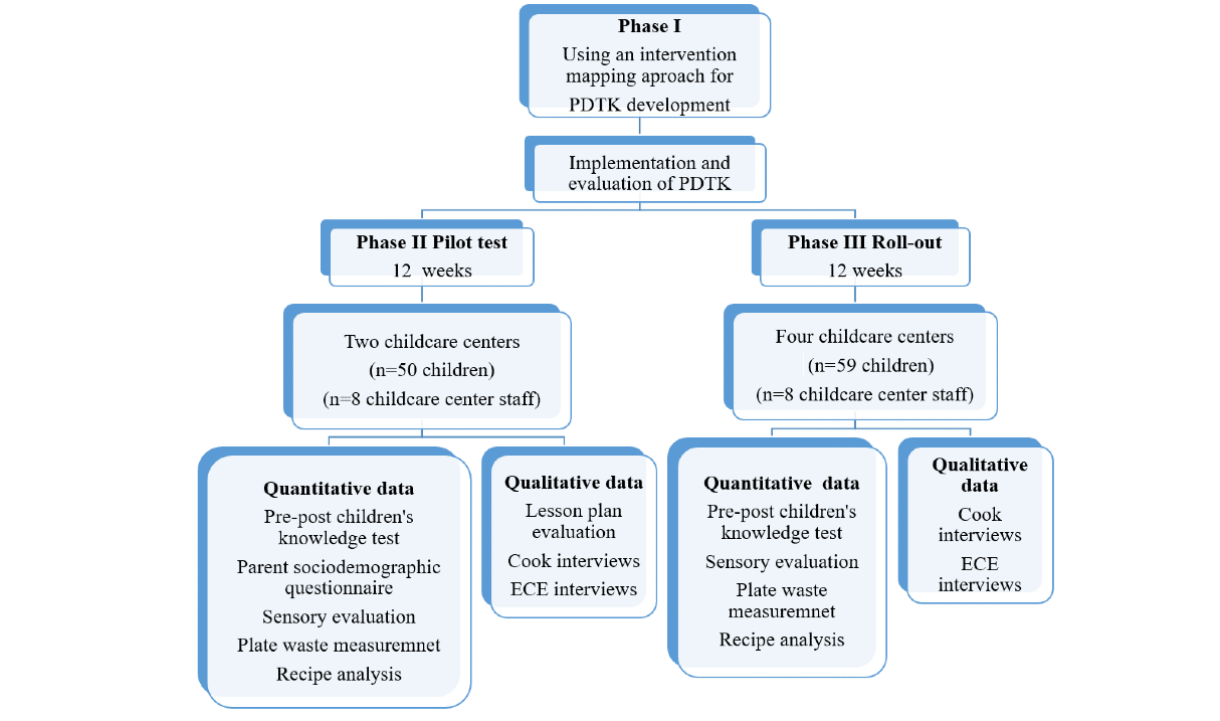
Figure 5. Flow chart showing the development of the Pulse Discovery Toolkit (PDTK) intervention, its implementation, and the evaluation process. ECE: early childhood